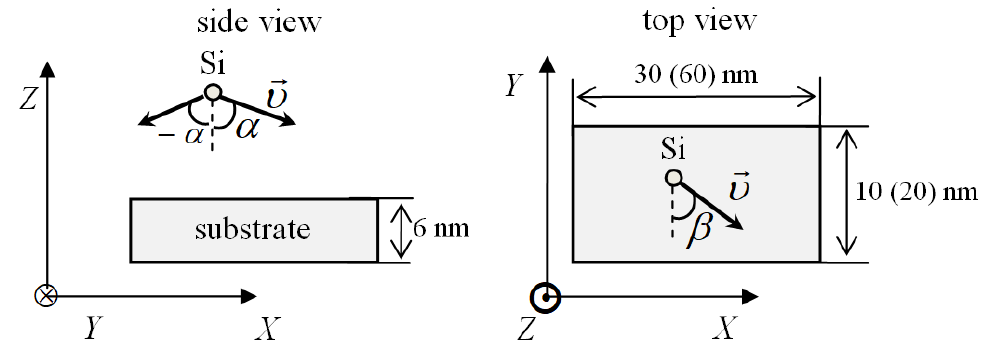
Figure 1. Schematic representation of the simulation area .